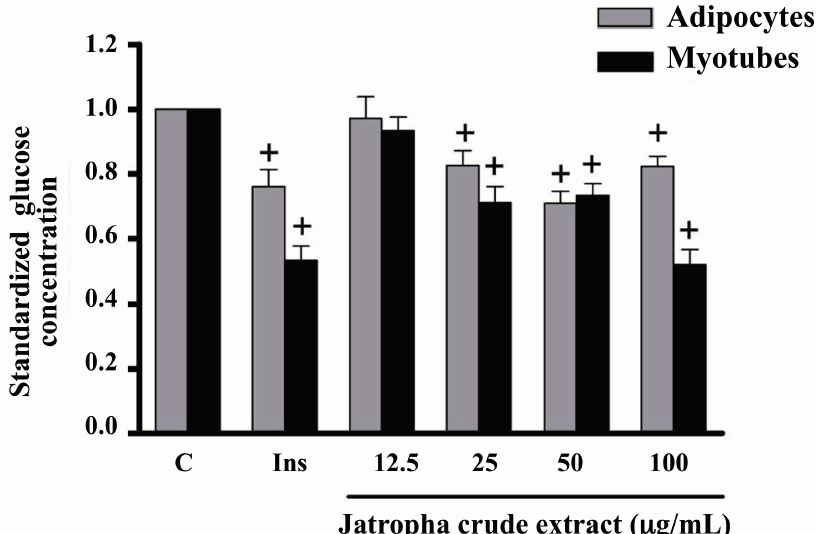
Figure 1. Effect of crude Jatropha extract on glucose uptake using cultured C2C12 myotubes and 3T3-L1 adipocytes. The crude extract stimulated glucose uptake in both cell lines. Cells were treated with different concentrations of the extract, and glucose was measured in culture supernatants after 4 h of treatment by the glucose oxidase technique. Bars represent C (control plus DMSO as vehicle), Ins (100 nM insulin), and crude Jatropha extract at increasing concentrations. Bar values correspond to the arithmetic mean of glucose concentration for each treatment/Control glucose concentration, n = 6. + Indicates p < 0.05 for ANOVA and Dunnett’s multiple-range tests. Error bars represent